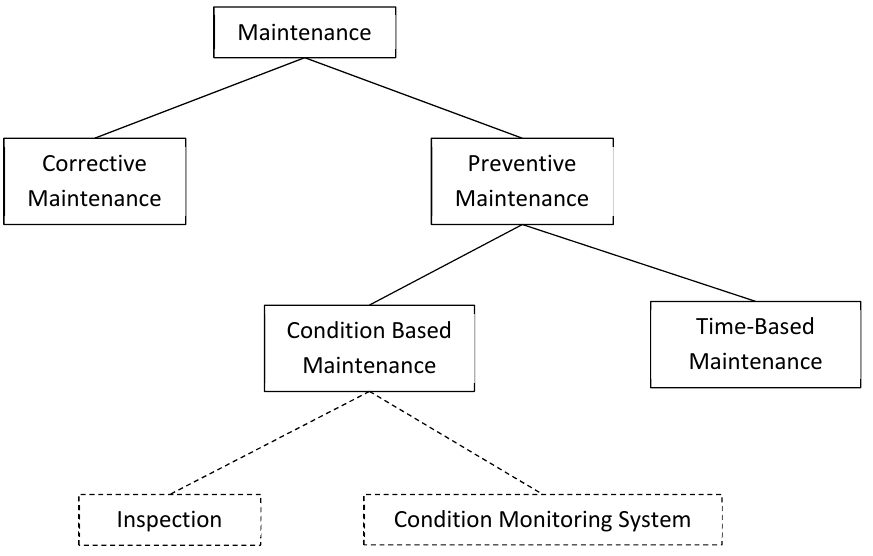
Figure 5. Maintenance strategy of DTOcean [45].